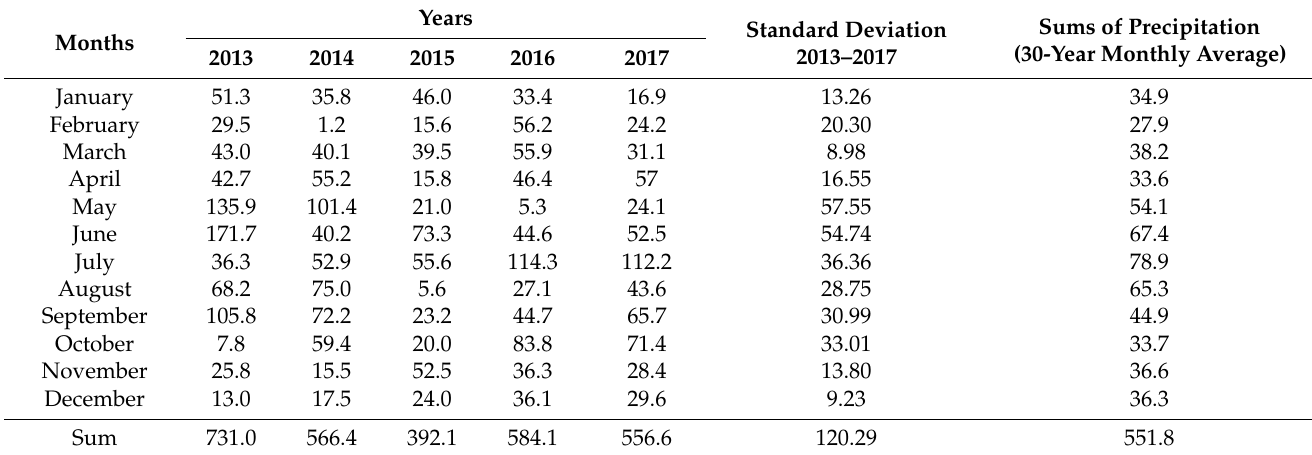
Table 3. Monthly total precipitation (mm) over the period